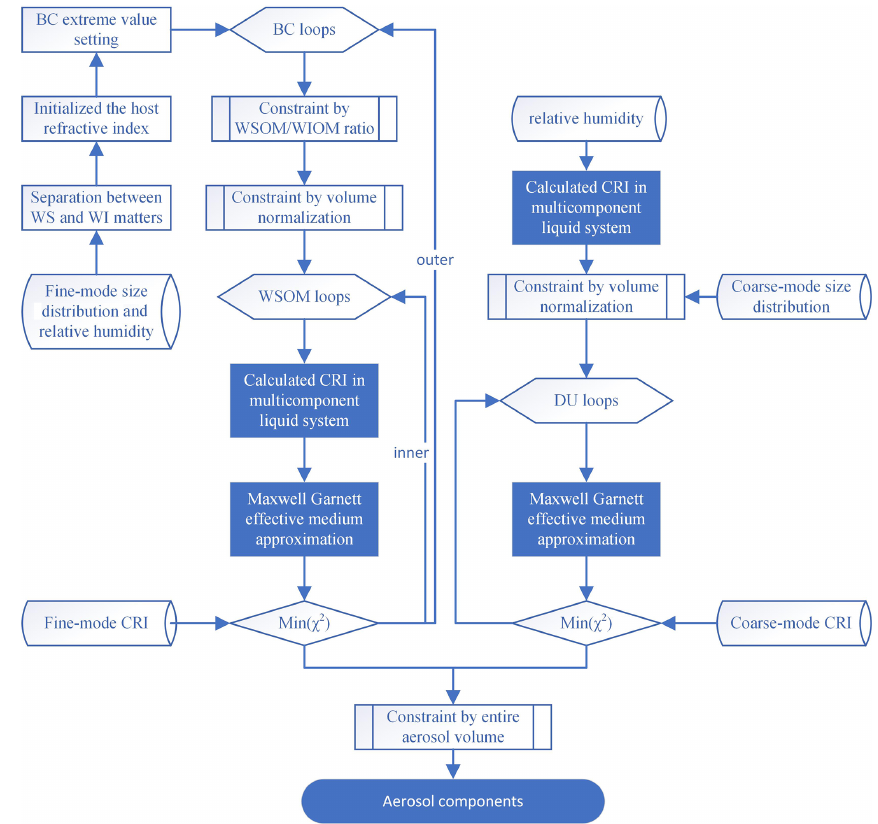
Figure 4. Flowchart of the aerosol component classification inversion